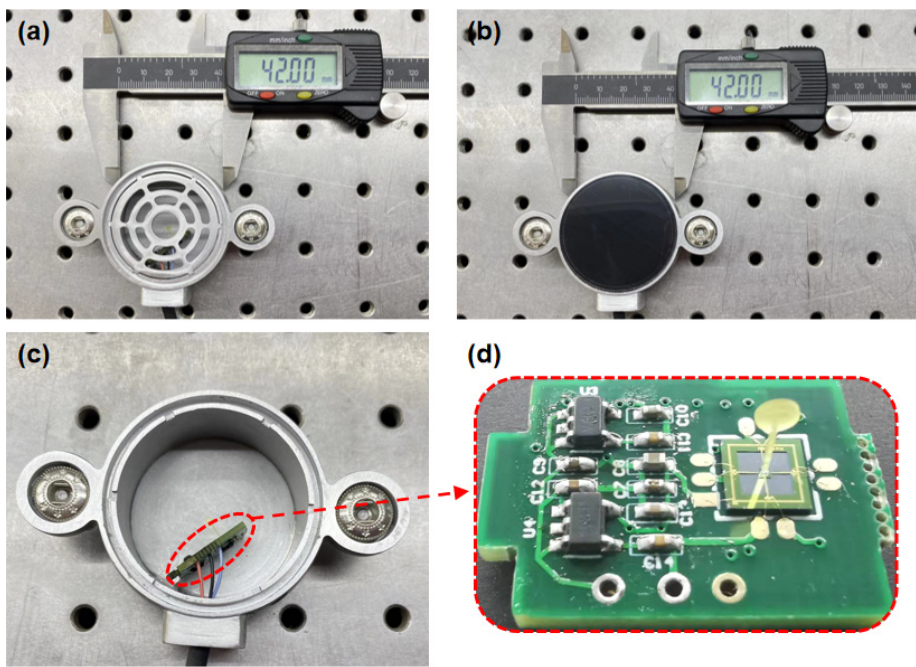
Figure 13. Overall packaging of MEMS heart sound sensor. ( a ) The package structure is supported within the sensor. ( b ) Waterproof and sound-permeable membrane encapsulation. ( c ) Internal structure of bionic MEMS heart sound sensor. ( d ) Heart sound signal preprocessing circuit.